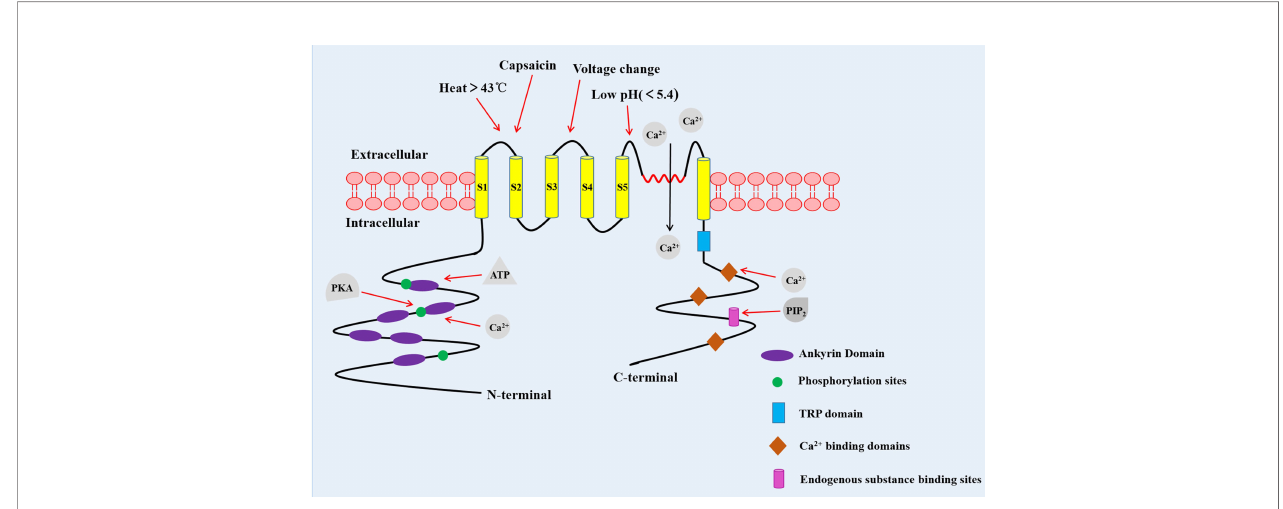
FIGURE 1 | The structure of the TRPV1 channel. TRPV1 channel is a homologous tetramer composed of four subunits, with six-transmembrane domains and a pore-forming hydrophobic group between the fi fth and sixth transmembrane domains. The N-terminal contains several phosphorylation sites and six ankyrin repeat domains. The C-terminal has a TRP domain, multiple calmodulin blinding domains and binding sites of endogenous substance. PKA, Protein kinase A